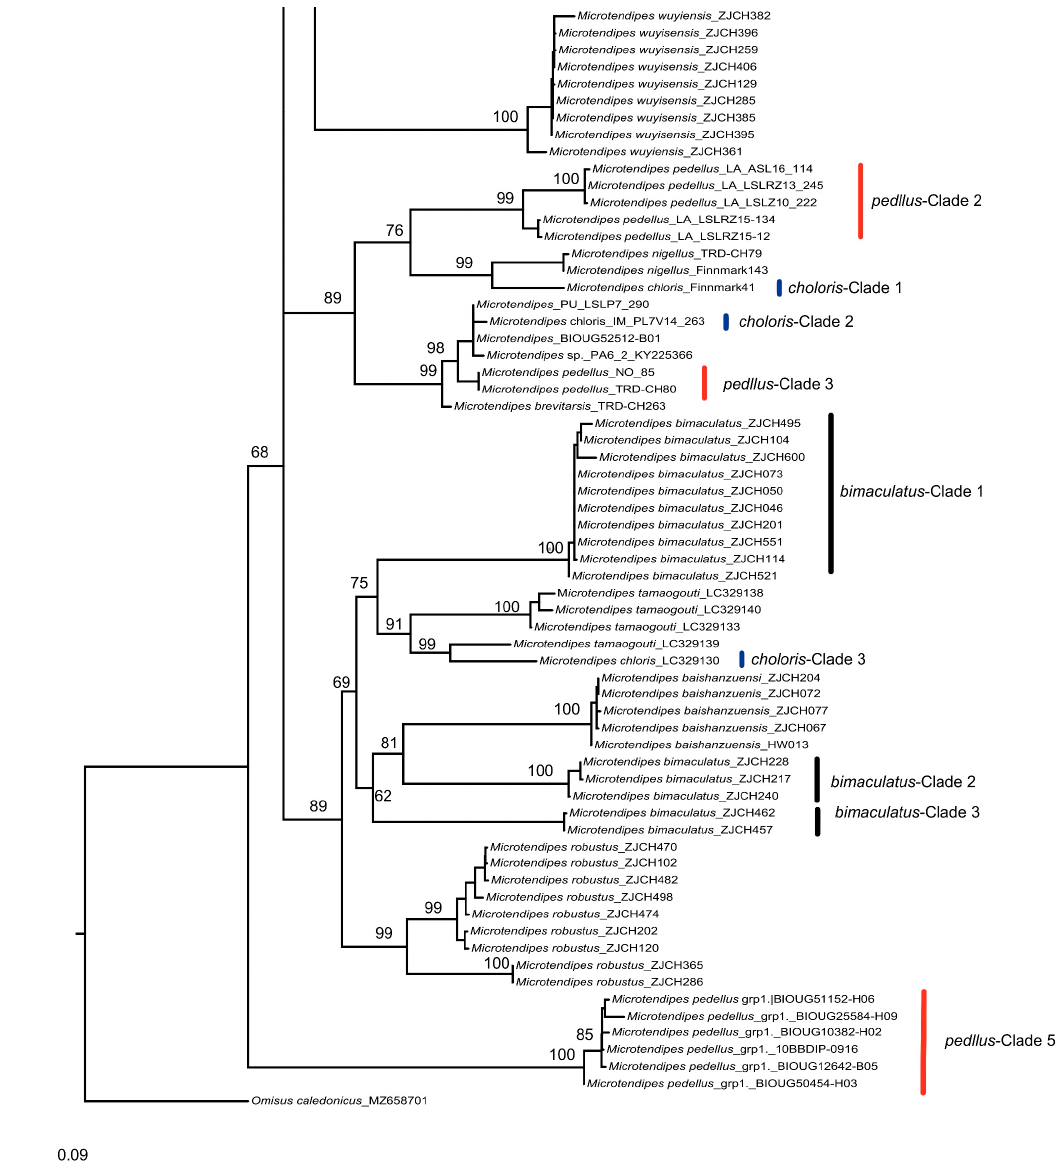
Figure 1. Maximum-likelihood tree of Microtendipes species. The tree was based on partial COI sequences and the generalized time-reversible substitution model. Omisus caledonicus (Edwards) was used as an outgroup.